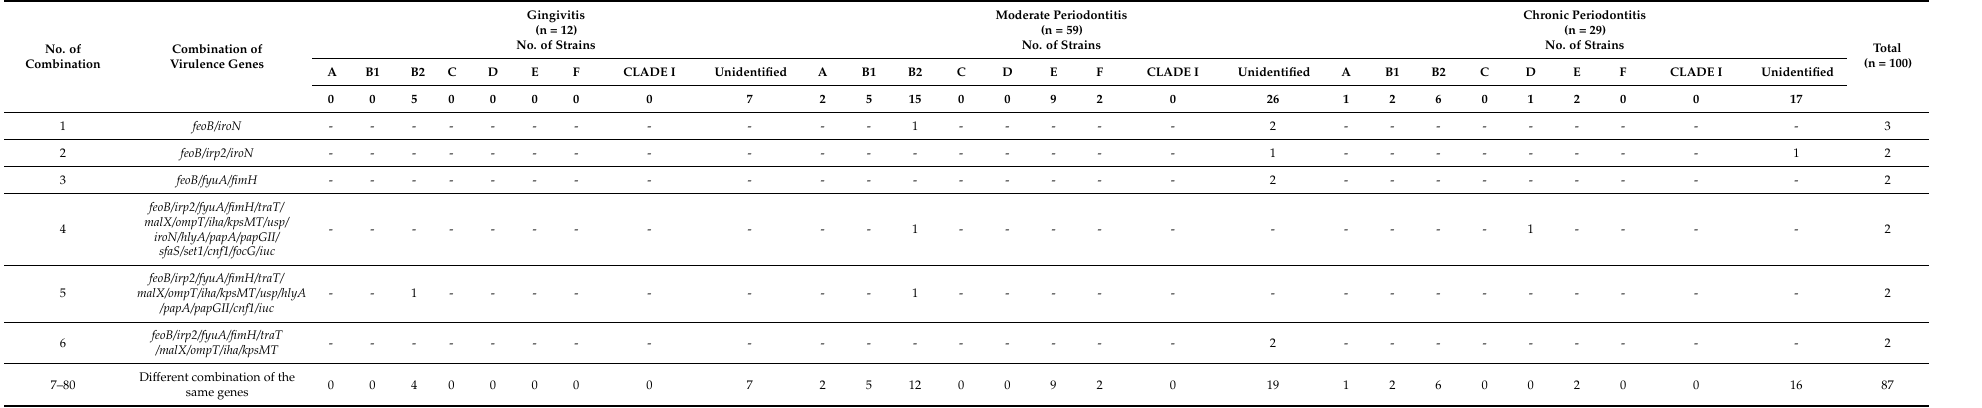
Table 3. Distribution of virulence gene association patterns in strains of E. coli